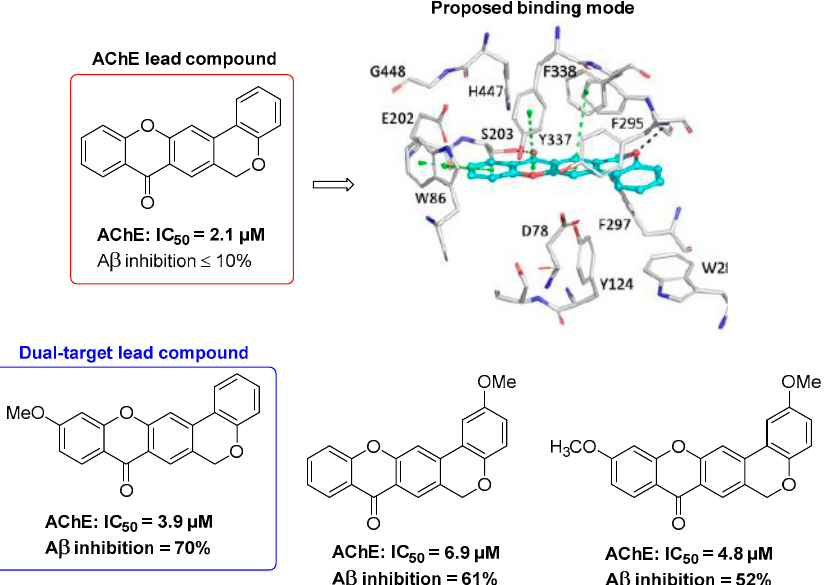
Figure 2. AChE inhibition, AChE binding mode, and A β aggregation inhibition of chromeno[3,4- b ]- 9 H -xanthen-9-ones.